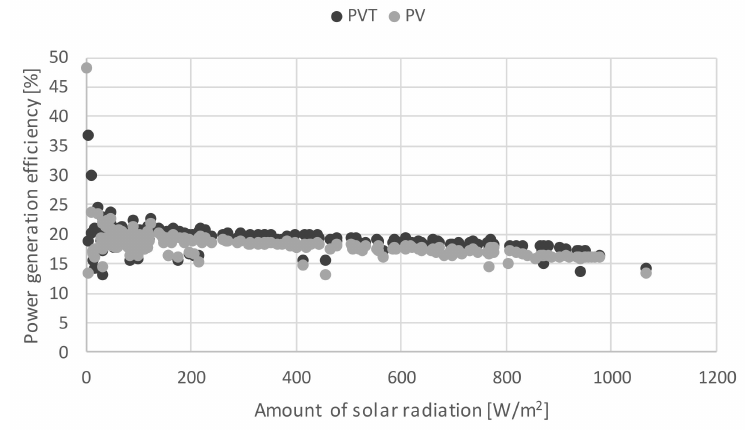
Figure 12. Power generation efficiency of PVT and PV panels.